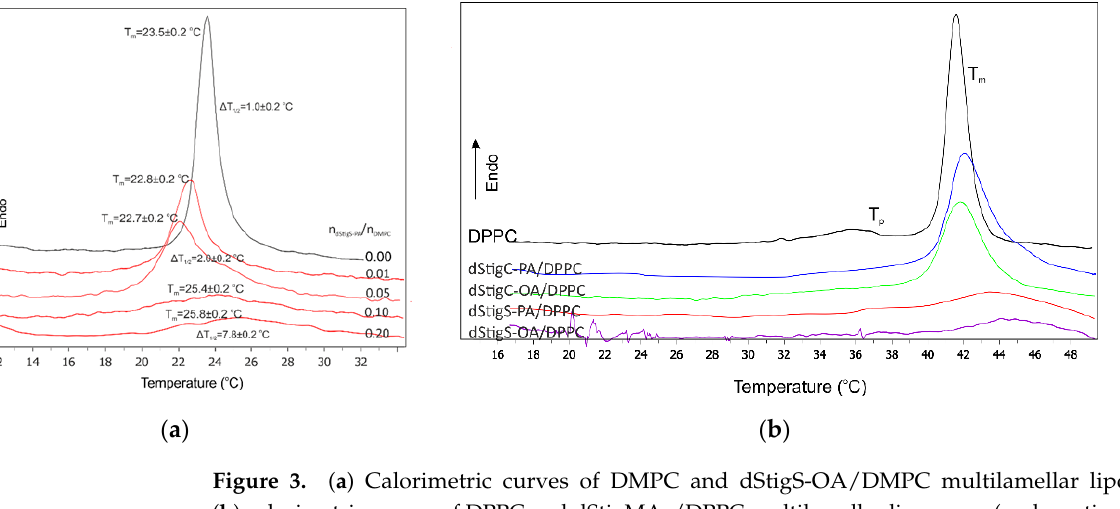
Figure 3. ( a ) Calorimetric curves of DMPC and dStigS-OA/DMPC multilamellar liposomes; ( b ) calorimetric curves of DPPC and dStigMAs/DPPC multilamellar liposomes (molar ratio of dStigMAs /DPPC = 0.2).